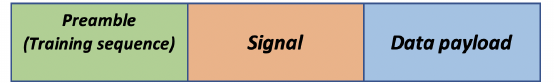
Figure 2. IEEE 802.11p PHY layer frame